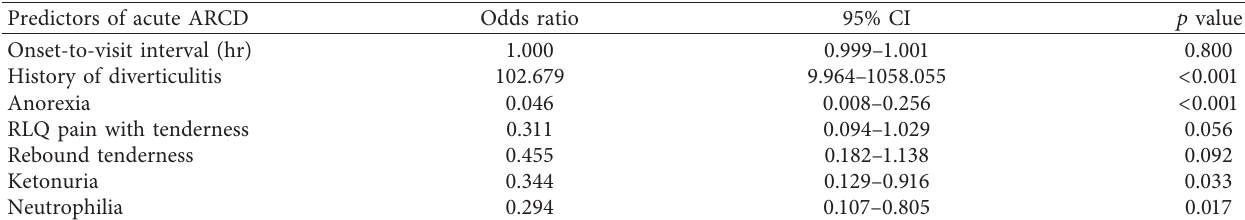
Table 3: Multivariate analysis of predictors of ARCD compared to